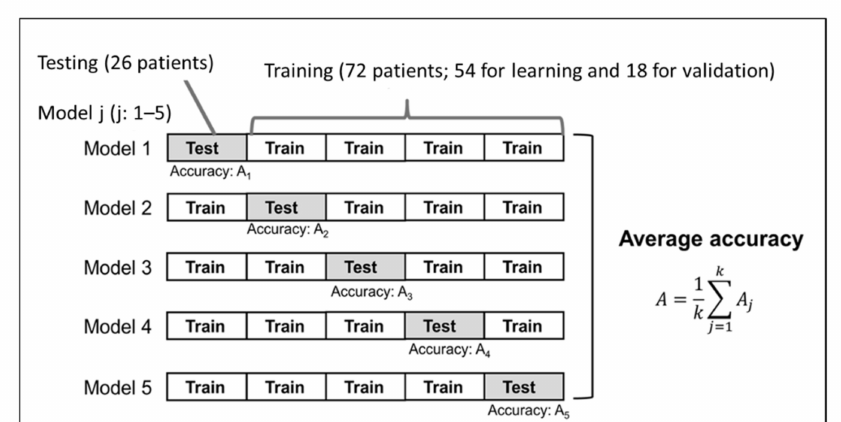
Figure 2. Generation and testing of the prediction model. The proposed neural network model with 5-fold cross-validation was built in the model training